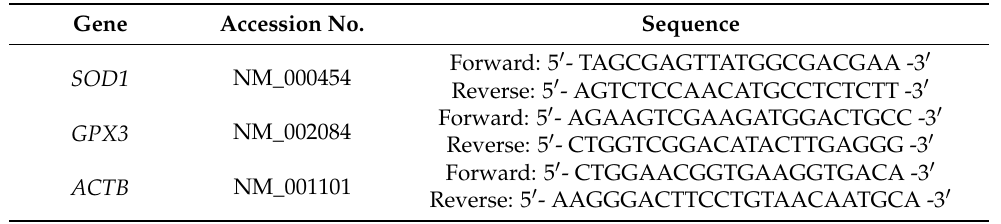
Table 1. Primer sequence of the target genes for real-time